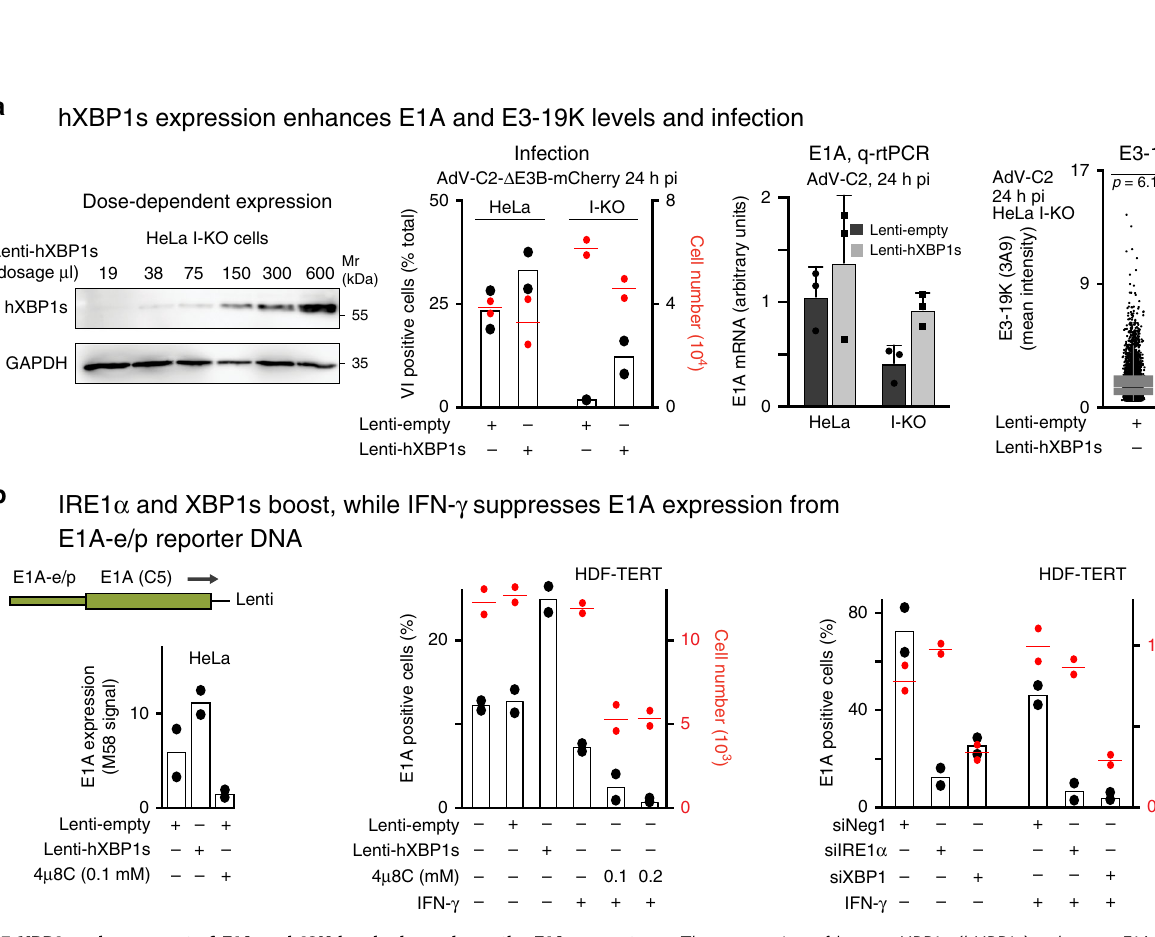
Fig. 4 19K forms a complex with IRE1 α in the ER. a Schematic representation of tripartite split-GFP lumenal domain (LD) constructs used in ER-lumenal GFP complementations. Green fl uorescence is restored when proteins containing the GFP10 and GFP11 domains are in close proximity together with the core GFP1 – 9 targeted to the ER lumen. b Interaction of C2 19K-LD with IRE1 α -LD but not PERK-LD. HeLa cells co-transfected with C2 19K-LD-GFP11, SS- (signal sequence)-GFP1 – 9-HDEL, and Flag-IRE1 α -GFP10 or PERK-LD-GFP10 were fi xed and stained with anti-19K (3A9) and anti-Flag antibodies and DAPI (nuclei). Confocal images were segmented with CellPro fi ler using DAPI as a nuclear mask, and the reticular ER signal was measured in a ten-pixel area around the nuclei. Arrows indicate high-intensity split-GFP complementation signals in IRE1 α -LD-transfected cells, and arrowheads low-intensity split-GFP complementation. Zoomed in representative immuno fl uorescence micrographs of split-GFP complementation in SS-GFP1 – 9-HDEL, IRE1 α -LD-GFP10, and C2 19K-LD-GFP11-transfected cells. Cells were imaged with Leica SP8 microscope using Nyquist x – y – z sampling with ×63 objective. Following acquisition, images were deconvolved using SVI Huygens using theoretical point-spread function (PSF) automatically calculated from the imaging parameters. Split- GFP complementation signals appear in the region of ER tubules where 19K and IRE1 α colocalize. Flag and 19K-positive cells ( n = 492 for IRE1 α -LD and n = 40 for PERK-LD) were plotted for GFP intensity, and the percentage GFP-positive cells is indicated. Data are presented as median with fi rst and third quartiles, and whiskers as boxes and lines, respectively. Statistical tests were performed using Wilcoxon two-sided nonparametric test, and two independent experiments gave similar results (lower right panel).